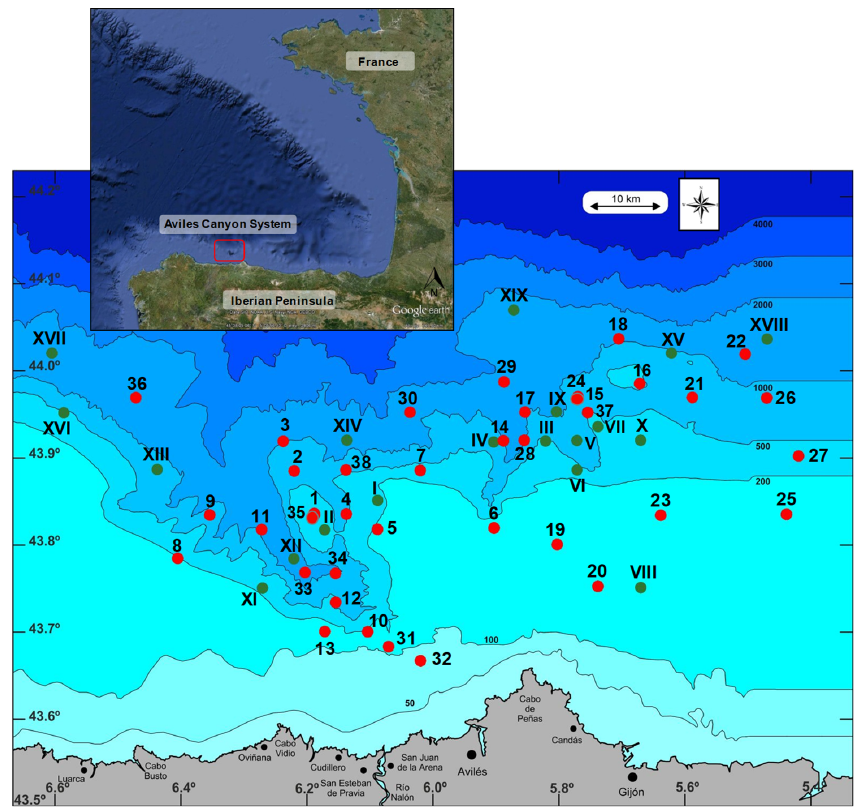
Figure 1. Location of the ACS, and position of the stations sampled on this study area. Green circles with roman numerals mark the stations where only sediment was collected. Red symbols with cardinal numerals mark the stations where sediment and infauna were collected.